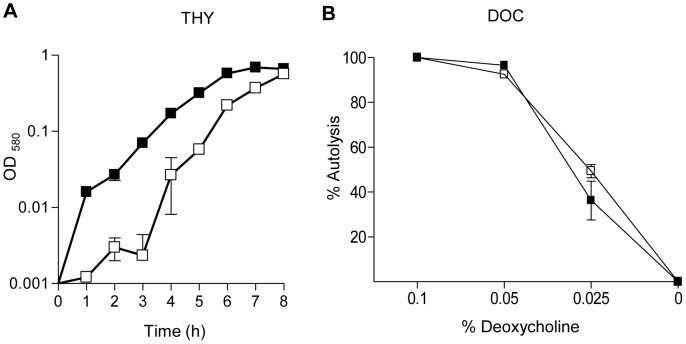
Growth of the wild-type and Δlgt strains in complete medium and susceptibility to DOC-induced lysis.(A) Growth of the wild-type and Δlgt strains in THY assessed by measuring broth culture log10 OD580 over time. (B) Proportion of bacteria surviving after incubation with increasing concentrations of DOC. Squares represent the wild-type strain, triangles the Δlgt strain. Error bars represent SDs, and when not visible are within the symbol.